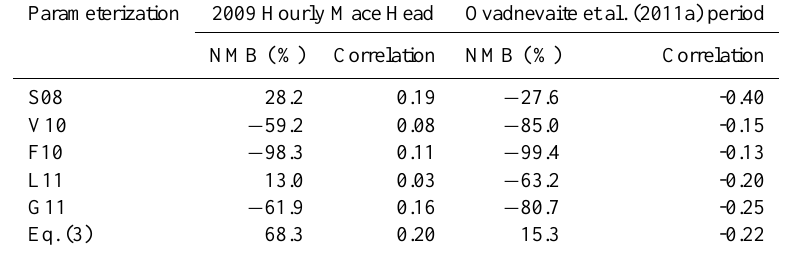
Table 4. Comparison of 2009 hourly GEOS-Chem marine POA surface concentrations and submicron OM observations from Mace Head.